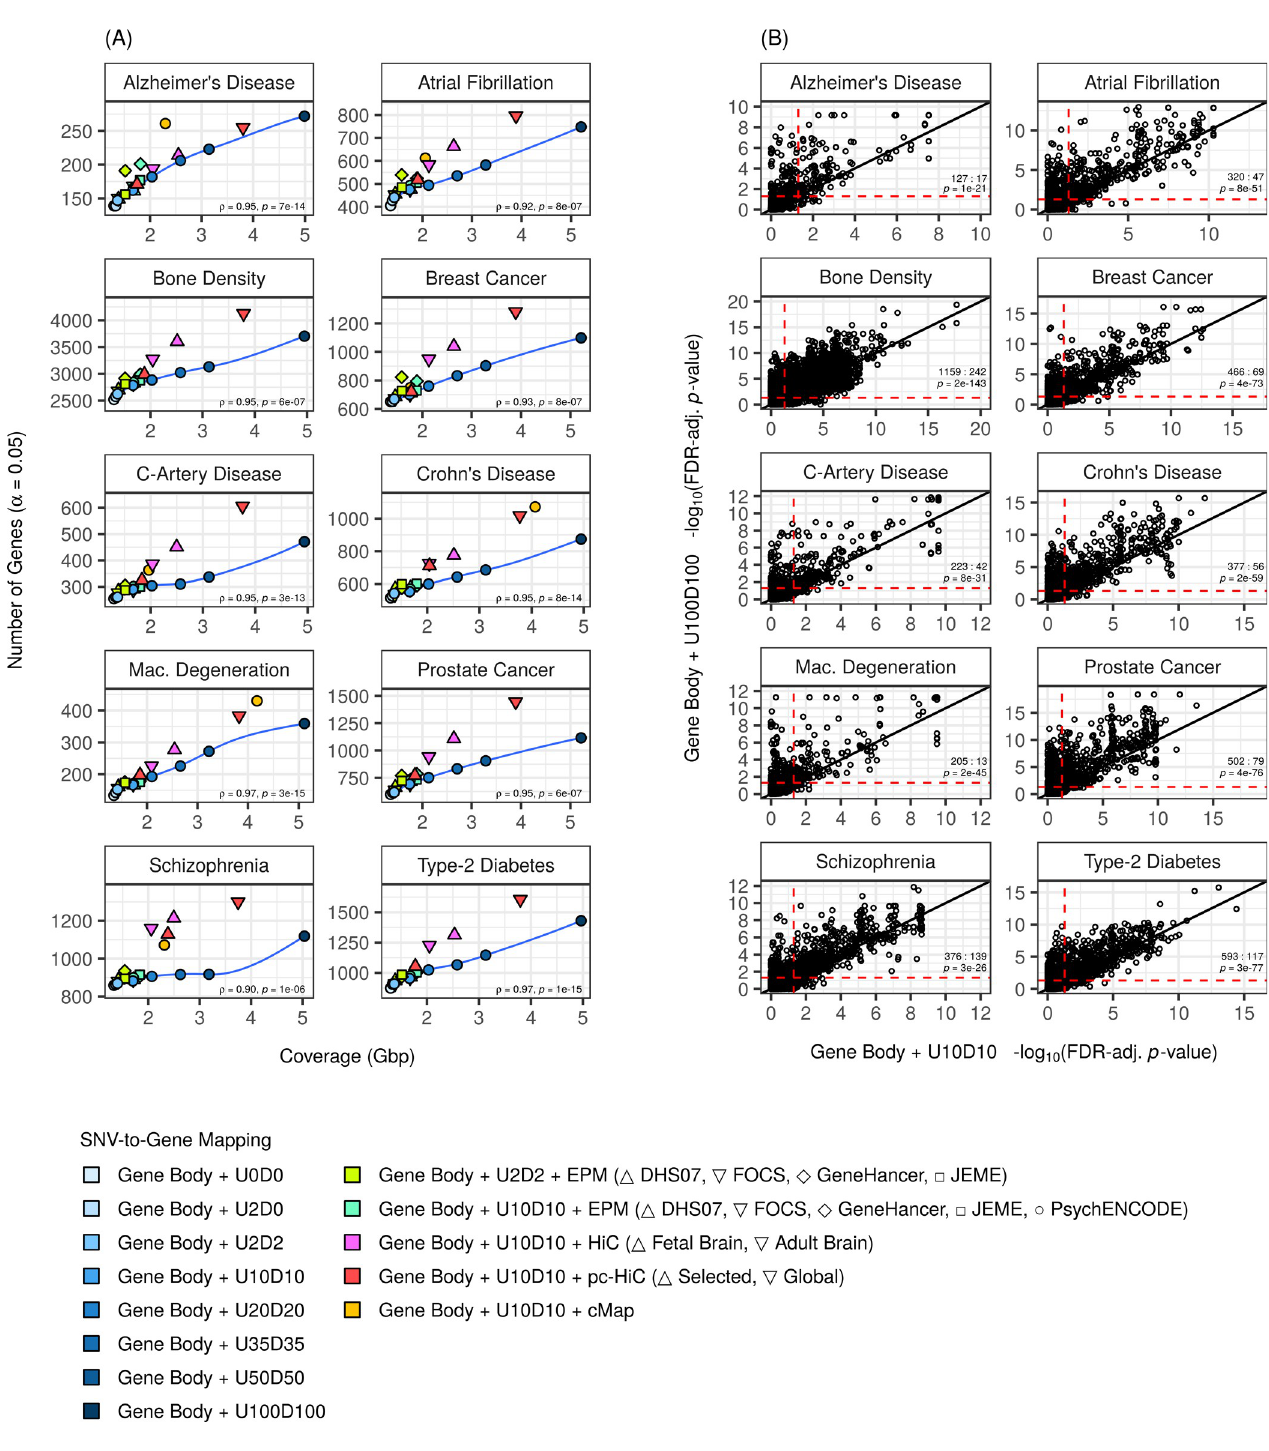
Fig 2. Larger SNV-to-gene mappings (by coverage) yield more significant genes. (A) The number of significant genes detected for diverse SNV-to-gene mappings as a function of their coverage (that is, the number of non-redundant base pairs covered by all features–gene bodies, flanks, and regulatory elements —defining a gene, summed across all genes). Blue, solid line shows trend (loess smooth) for flank-based mappings (including Gene Body + U0D0). For each phenotype, we reported Spearman’s rank correlation coefficient ( ρ ) and its associated p -value ( p ) for a test of positive correlation based on all mappings (including gene bodies with 250kb flanks, gene bodies with 500kb flanks, and gene bodies with 1000kb flanks, which are not depicted on the graphs themselves but provided in Table B in S2 Table). (B) Gene scores of individual genes (circles), comparing between a mapping with large flanks (that is, 100kb flanks) and a mapping with small flanks (that is, 10kb flanks, which is the baseline model). Black, solid line shows the identity line. Red, dashed line shows the significance